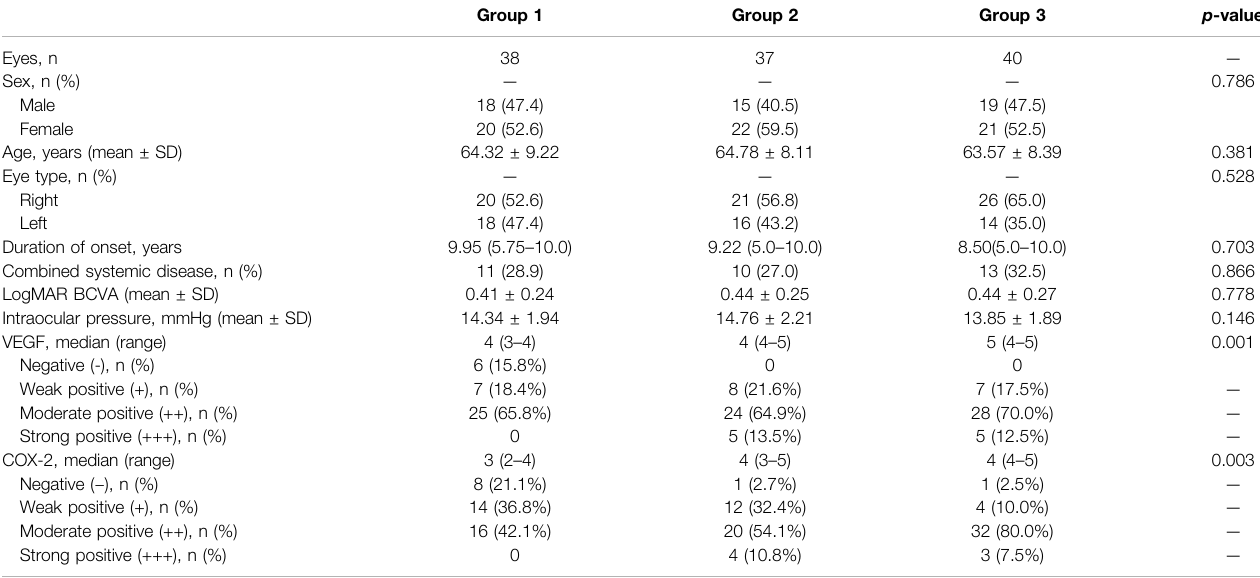
TABLE 1 | Demographic and clinical characteristics of the study